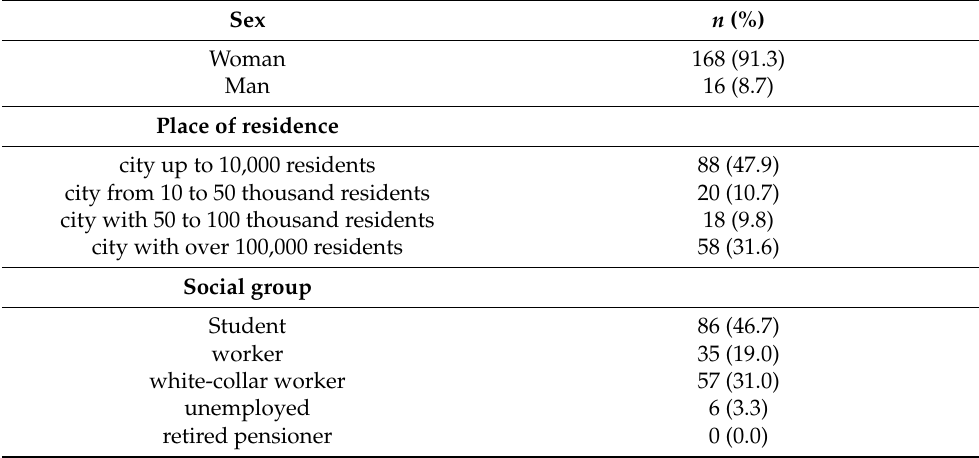
Table 1. Characteristic of study